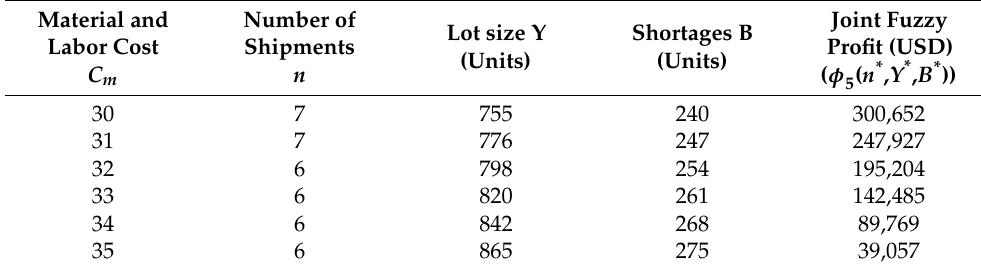
Table 19. Impact of the material and labor cost on the decision variables and joint fuzzy